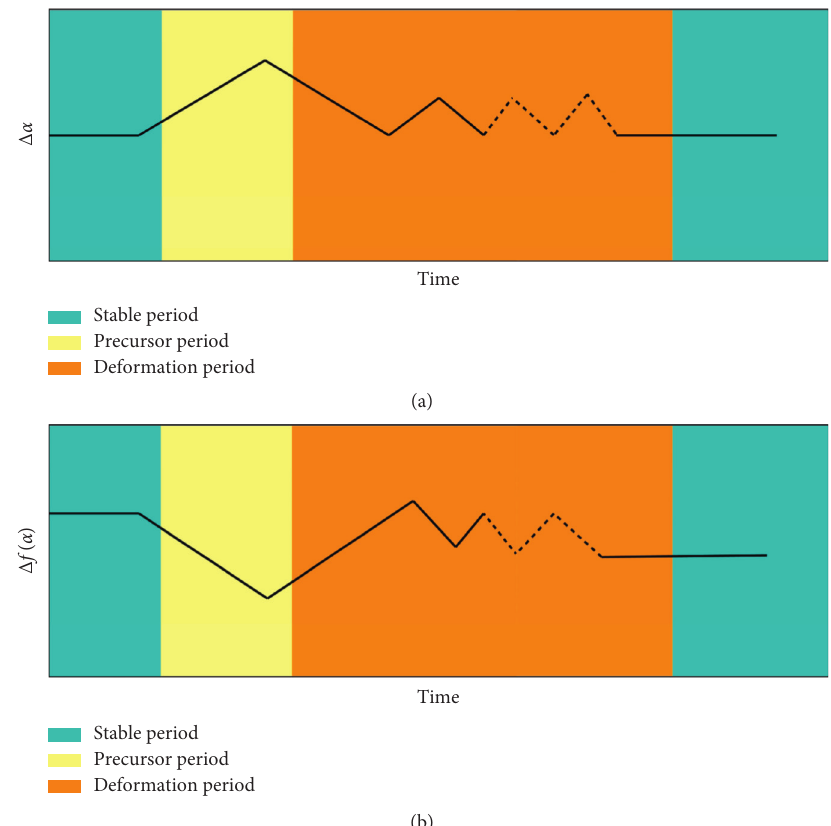
Figure 18: MF-DFA multifractal warning